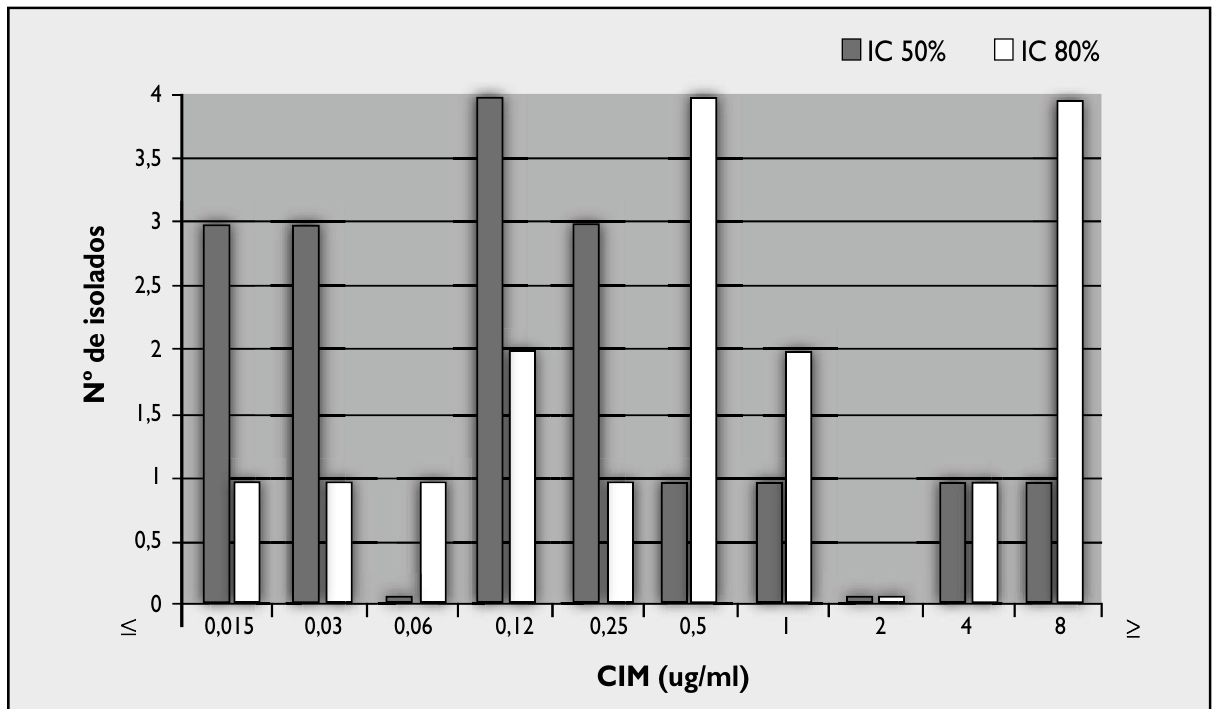
Figura 5 – Distribuição dos valores de CIM de itraconazol, calculados para índice de inibição de 50% e 80%, em isolados de espécies não- albicans do fl uido vaginal de 17